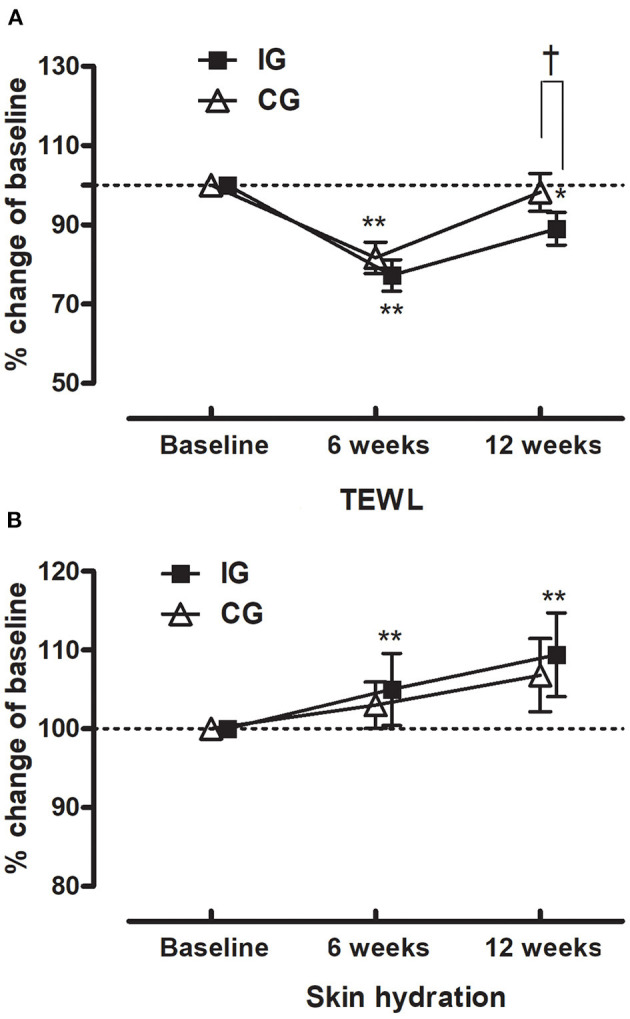
Changes in skin parameters in individuals receiving collagen tripeptide or placebo. (A) Changes in transepidermal water loss (TEWL). (B) Changes in skin hydration. *P < 0.05, **P < 0.01 by paired t-test comparisons with baseline values. P < 0.05 by two-sample t-test comparisons between values in the intervention group and the control group.